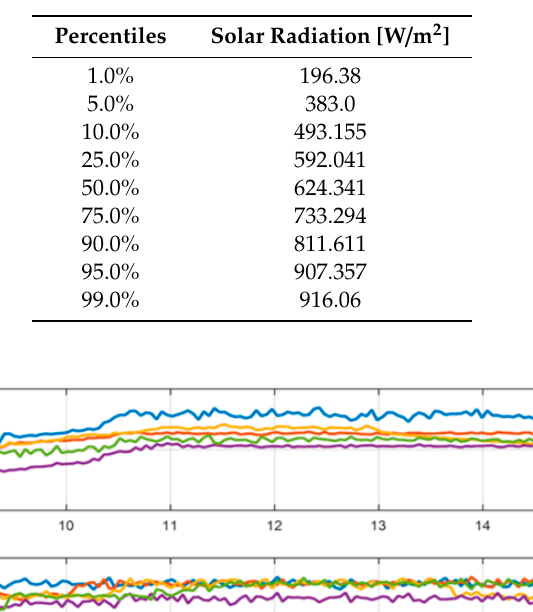
Table 8. Percentiles for solar radiation characterization.